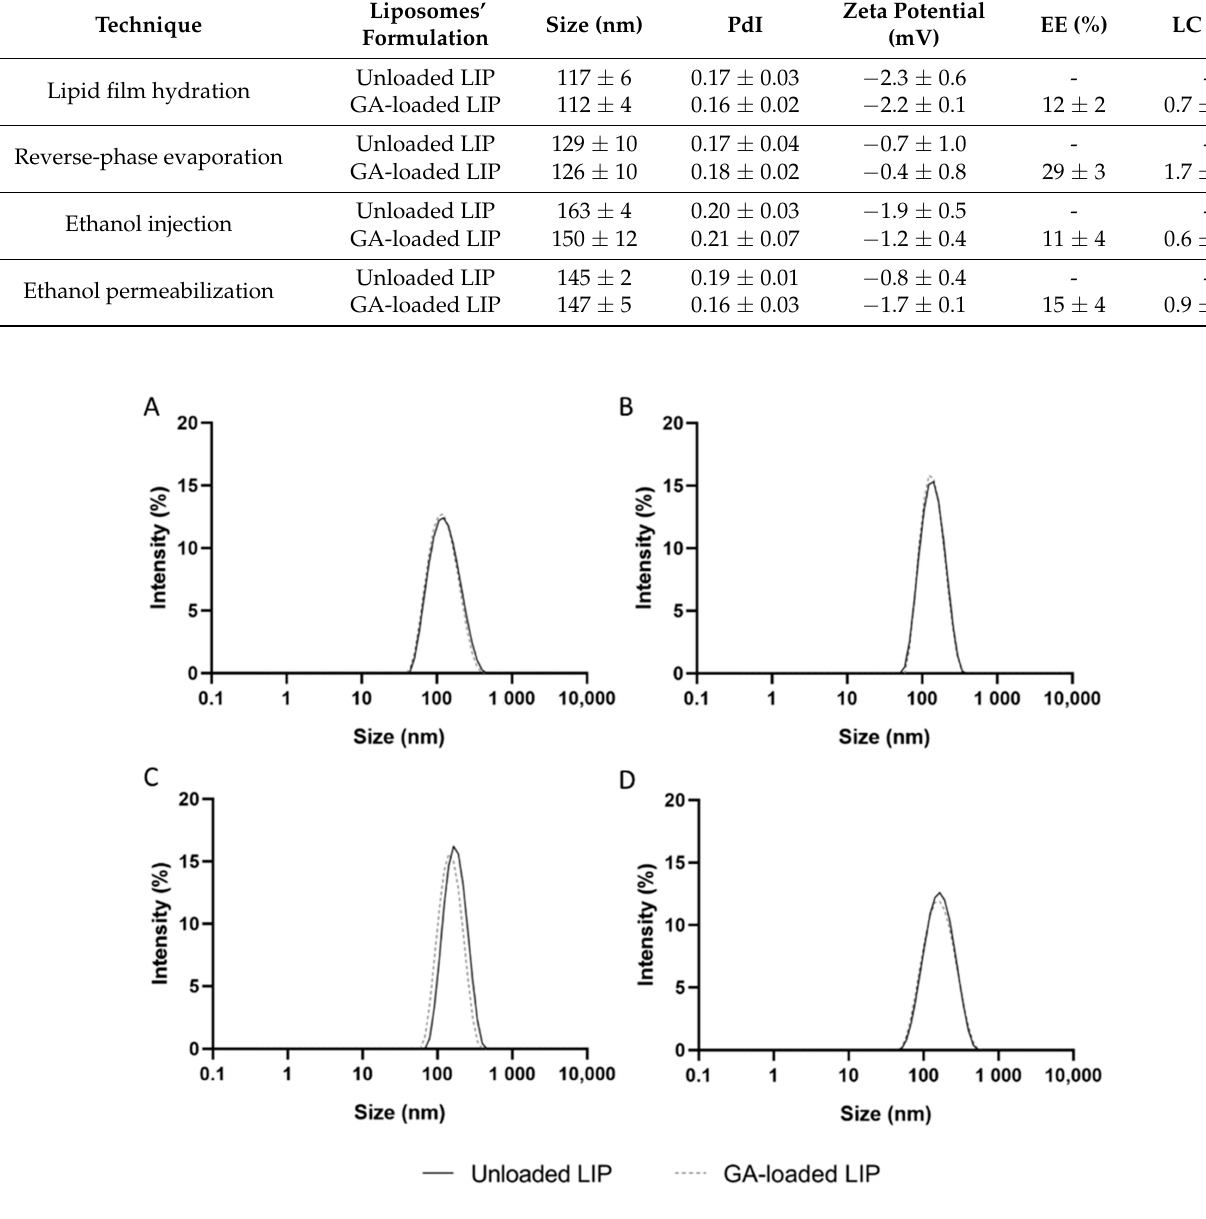
Figure 1. Size distribution by intensity of unloaded (black line) and GA-loaded liposomes (dashed gray line) produced by ( A ) lipid film hydration, ( B ) reverse-phase evaporation, ( C ) ethanol injection and ( D ) ethanol